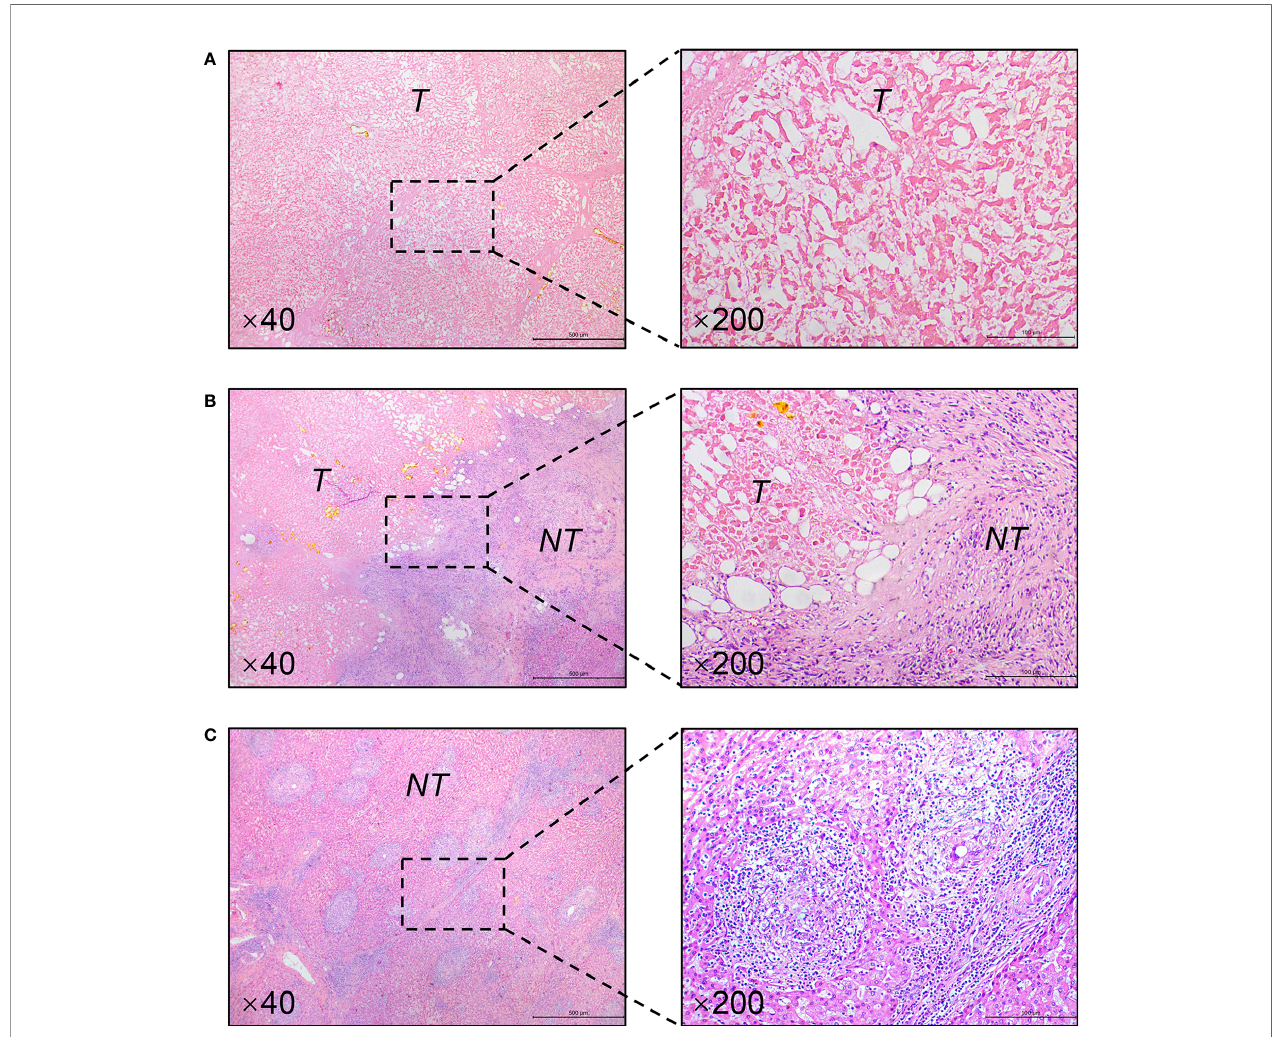
FIGURE 3 | Representative pathological fi ndings of resected specimens (H&E staining). (A) Complete necrosis of the tumor. (B) Massive in fi ltration of lymphocytes in the tumor-nontumor interface. (C) Typical granulomatous in fl ammation in the nontumor liver. Magni fi cation is showed in the lower left corner. T, tumor; NT, nontumor